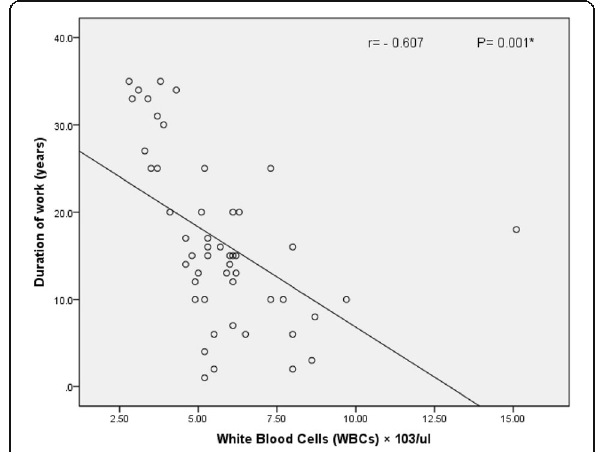
Fig. 2 Correlation between duration of work and WBCs